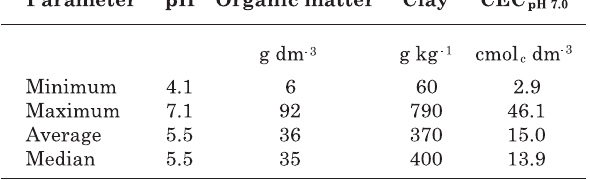
Table 1. Characterization of the pH values, the clay and organic matter (OM) of the soils used in this work